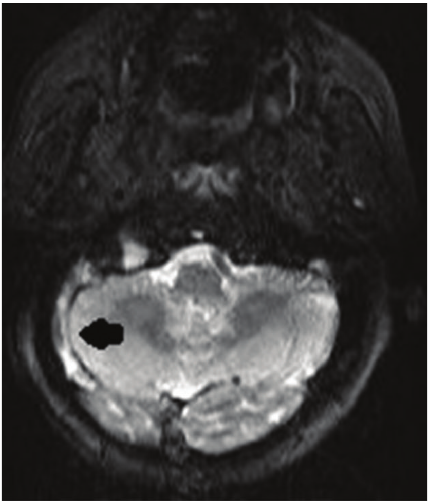
Figure 1: Air bubbles as seen in the brain CT of the right sigmoid sinus.